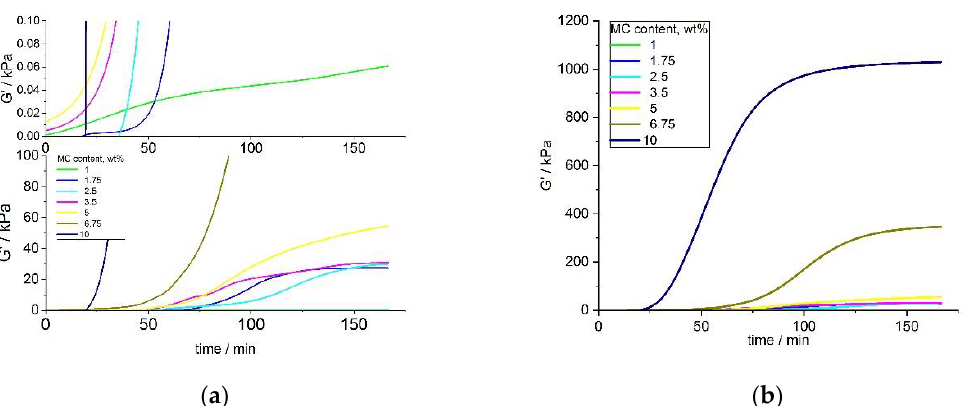
Figure 7. G’ versus time at 37 ° C for several MC concentrations — ( a ) enlarged view of the low G’ range, and ( b ) the whole G’ range.